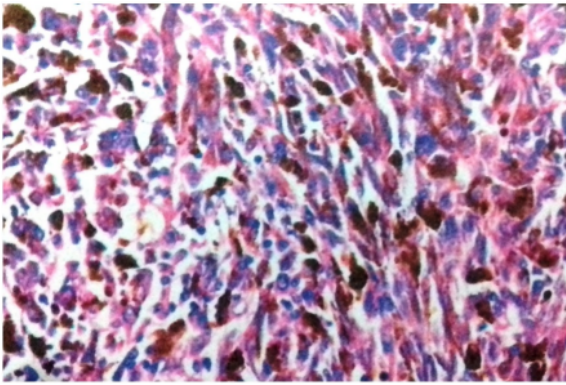
Figure 3: Histopathology demonstrating choroid tissue infiltration by a tumour arranged in sheets and fascicles with elongated spindle-shaped vesicular nuclei with prominent nucleoli and abundant melanin pigment (hematoxylin and eosin, original magnification 300x